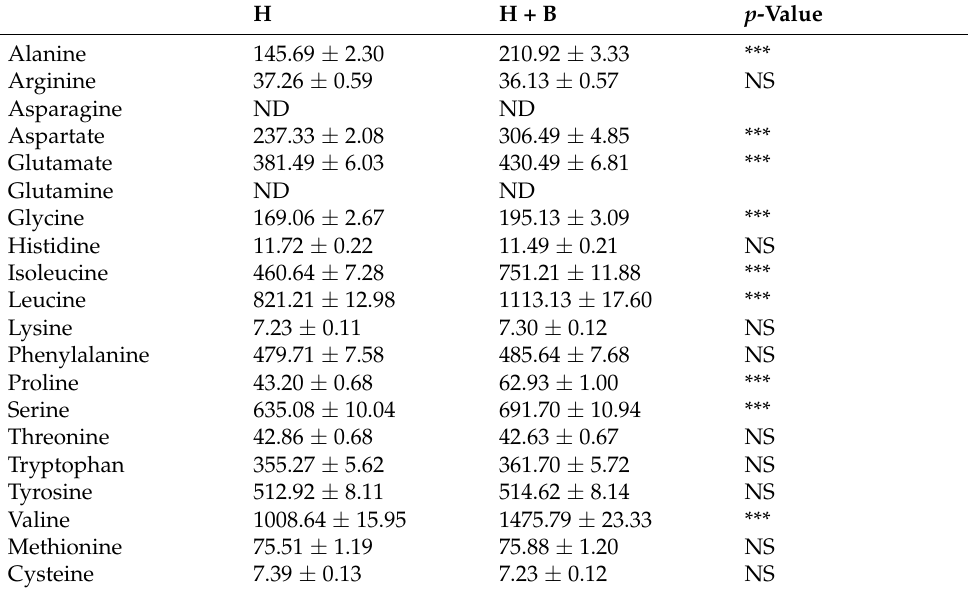
Table 1. Aminogram ( µ g g − 1 DW) in sunflower plants subjected to the treatments. H H + B p -Value Alanine 145.69 ± 2.30 210.92 ± 3.33 *** Arginine 37.26 ± 0.59 36.13 ± 0.57 NS Asparagine ND ND Aspartate 237.33 ± 2.08 306.49 ± 4.85 *** Glutamate 381.49 ± 6.03 430.49 ± 6.81 *** Glutamine ND ND Glycine 169.06 ± 2.67 195.13 ± 3.09 *** Histidine 11.72 ± 0.22 11.49 ± 0.21 NS Isoleucine 460.64 ± 7.28 751.21 ± 11.88 *** Leucine 821.21 ± 12.98 1113.13 ± 17.60 *** Lysine 7.23 ± 0.11 7.30 ± 0.12 NS Phenylalanine 479.71 ± 7.58 485.64 ± 7.68 NS Proline 43.20 ± 0.68 62.93 ± 1.00 *** Serine 635.08 ± 10.04 691.70 ± 10.94 *** Threonine 42.86 ± 0.68 42.63 ± 0.67 NS Tryptophan 355.27 ± 5.62 361.70 ± 5.72 NS Tyrosine 512.92 ± 8.11 514.62 ± 8.14 NS Valine 1008.64 ± 15.95 1475.79 ± 23.33 *** Methionine 75.51 ± 1.19 75.88 ± 1.20 NS Cysteine 7.39 ± 0.13 7.23 ± 0.12